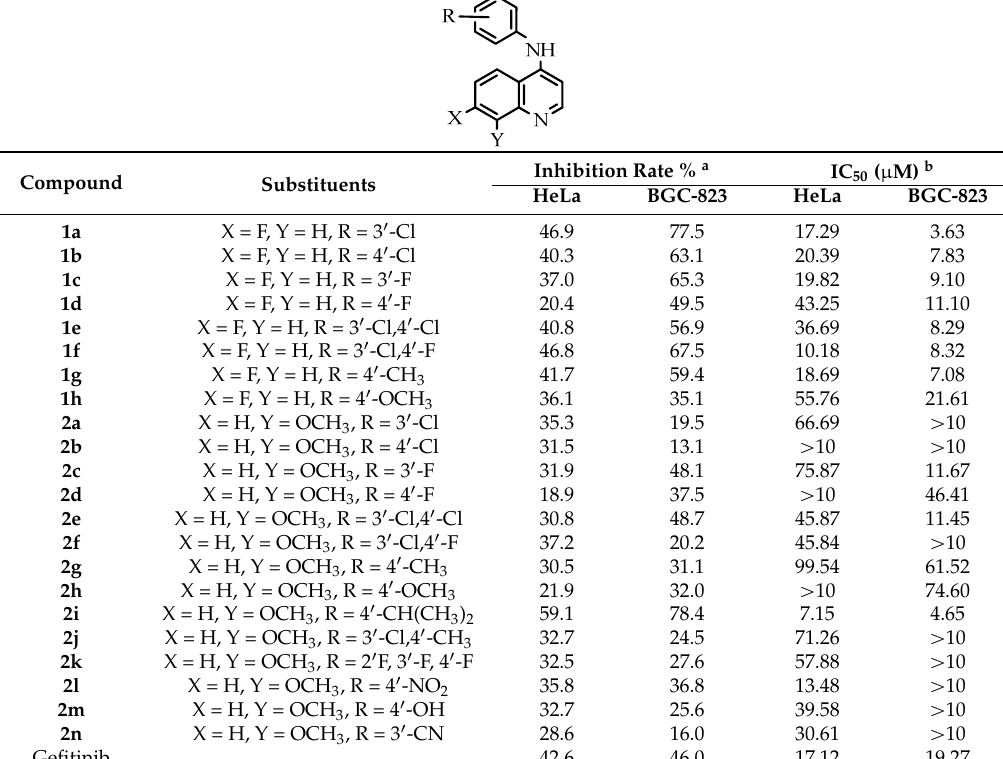
Compound Substituents